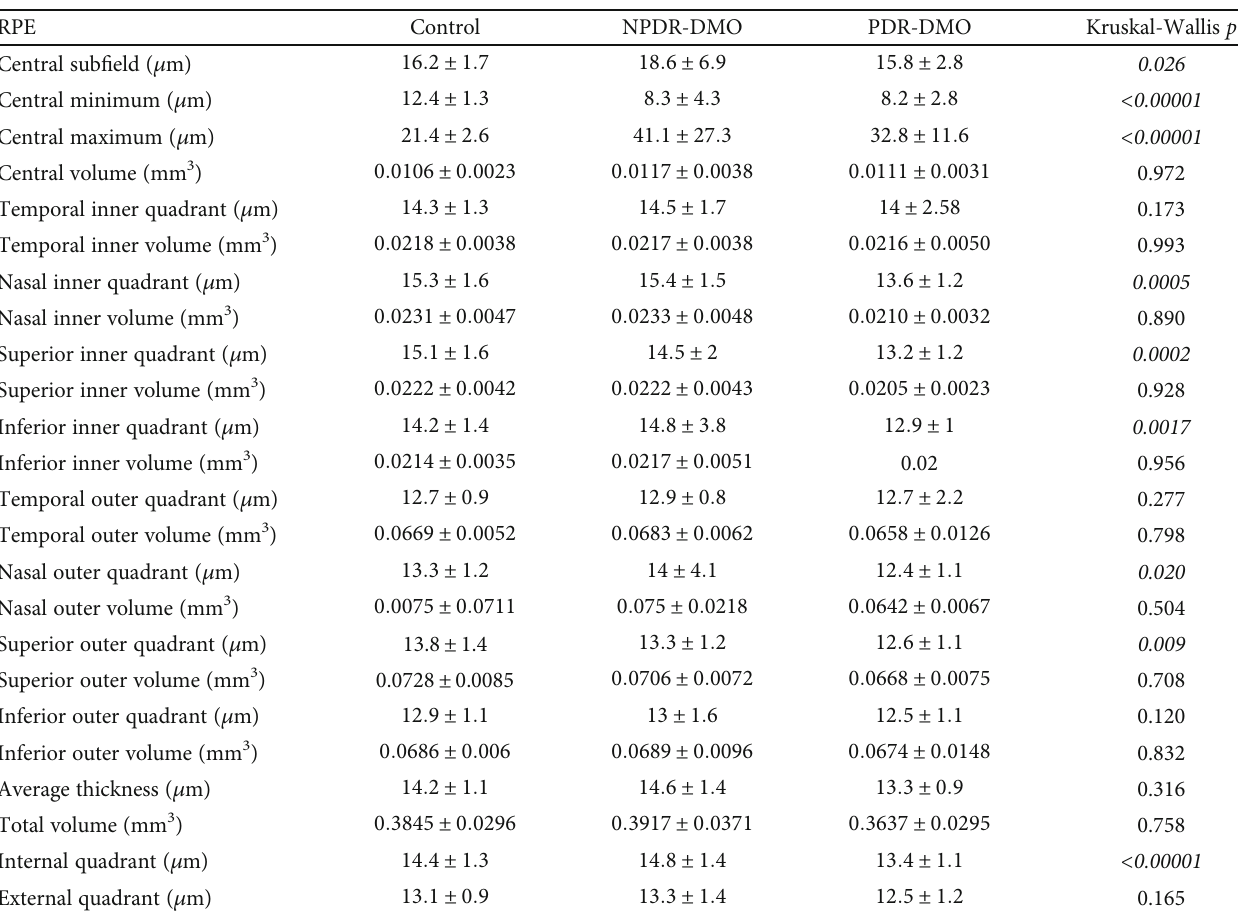
Table 2: RPE thickness and volume in each ETDRS macular map